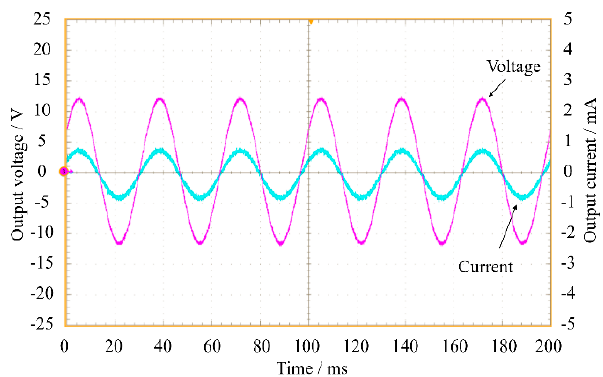
Figure 4. Typical PEH output voltage (in magenta) and output current (in cyan).